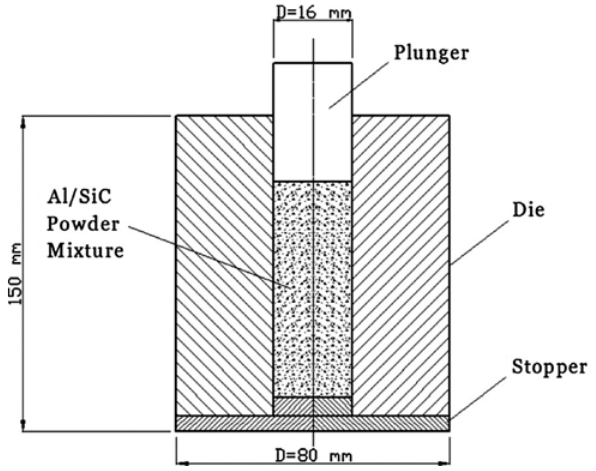
Figure 3: Schematic diagram of the cold compaction die used for the preparation of Al/SiC composites. Reproduced with permission from Ain Shams University (ScienceDirect)